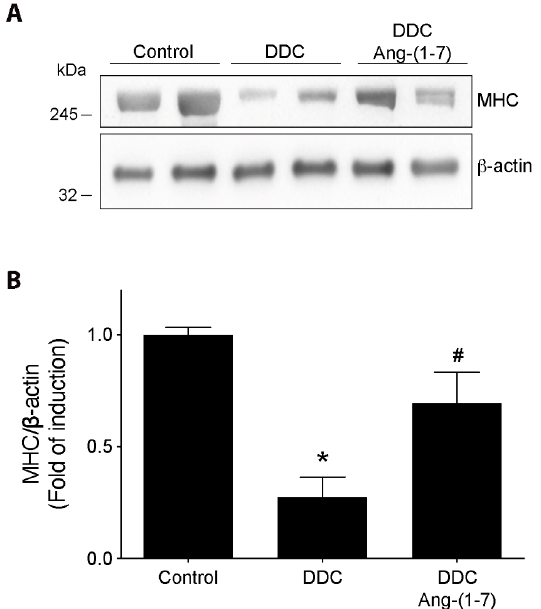
Figure 5. Preventive effect of Ang-(1-7) on decreased myosin heavy chain (MHC) protein levels in gastrocnemius from DDC-treated mice. C57BL/6J male mice were fed for six weeks with a standard diet (Control) or DDC-supplemented diet (DDC) with or without Ang-(1-7) (through osmotic pumps). For three independent experiments, five mice were used for each experimental condition. ( A ) At the end of 6 weeks the mice were sacrificed, gastrocnemius muscle was removed, and protein extraction was performed to detect MHC protein levels by western blot. β -actin was used as the loading control, and molecular weights are depicted in kilodaltons. ( B ) Densitometric analysis of the bands is expressed as fold of induction relative to control. Values represent the mean ± SEM. (* p < 0.05 vs. Control, # p < vs. DDC. One-way ANOVA, Tukey’s multiple comparisons